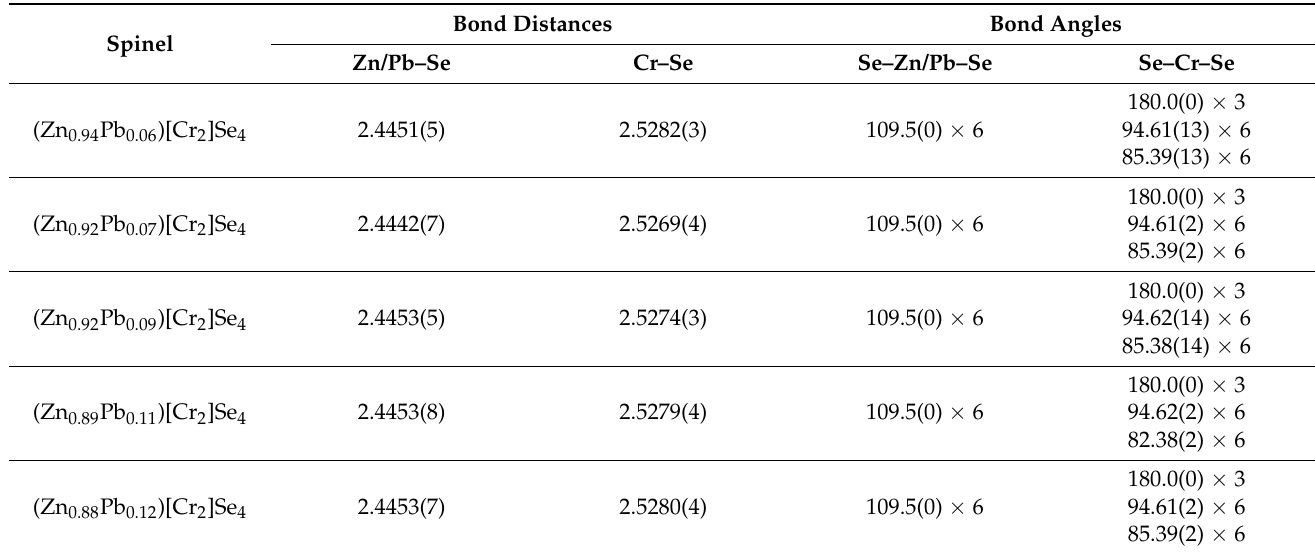
Figure 5. Dependence of the lattice parameters of Zn 1-x Pb x Cr 2 Se 4 single crystals on the Pb amount. The positional parameter of Se ( u ) is a measure of the anion sublattice distortion from the cubic-close packing. The value of u is the same for all obtained single crystals. Its value increases slightly compared to the ideal value of u = 0.250 (Table 3). The admixture of lead does not significantly affect the u -value. The same is observed in the metal–metal and metal–selenium distances (Table 4), where the differences are insignificant [22]. The structure refinement parameters, the selected bond distances, and angles are shown in Tables 3 and 4. Table 4. Selected interatomic distances (Å) and bond angles (deg) of the Zn 1-x Pb x Cr 2 Se 4 spinel single